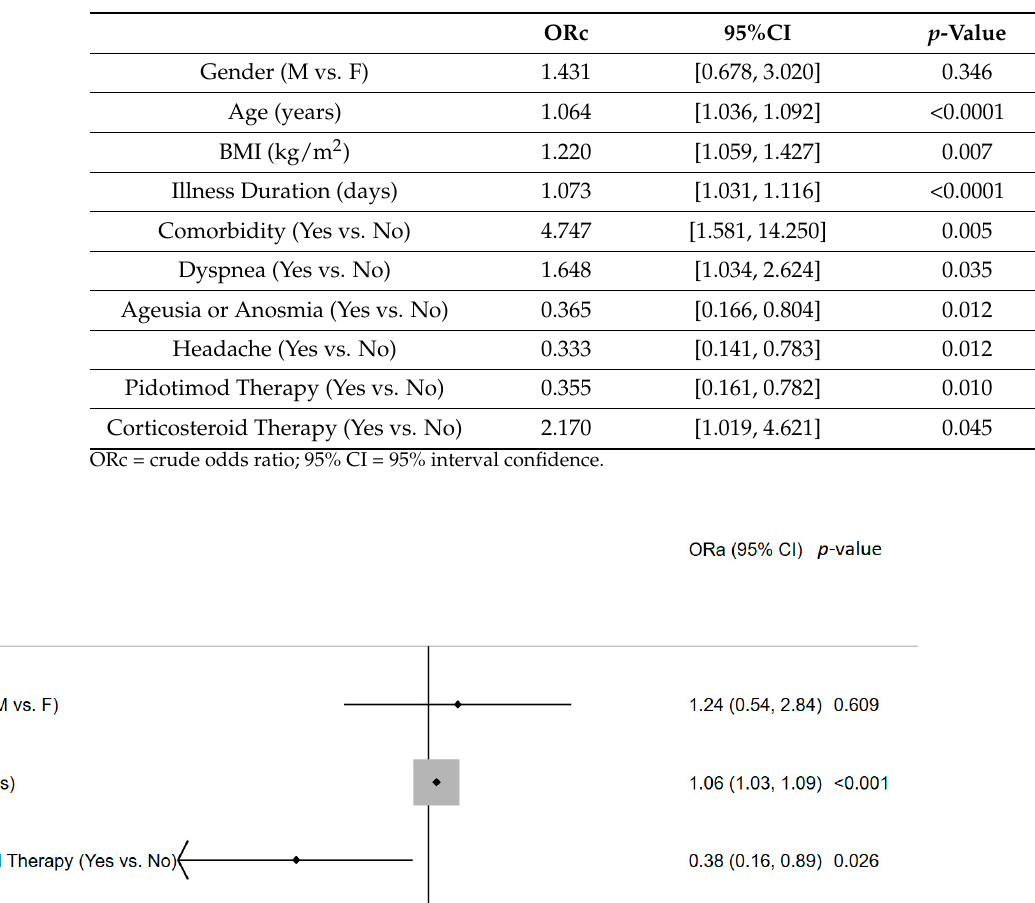
Table 4. Crude odds ratio and corresponding 95% CI for ER access/hospitalization.